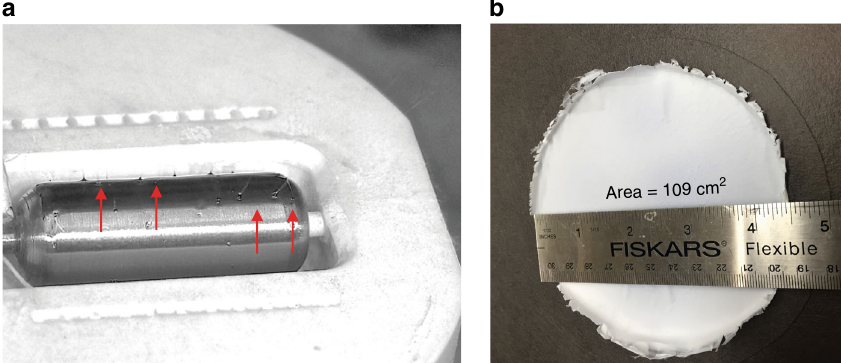
Fig. 6 Image of the rotating electrode and the collected sample on a carbon paper. Needle-free electrospinning can produce homogeneous and uniform fi lms over a large area. a Drum cylinder with multiple Taylor-cones (some are pointed at by red arrows) emerging on the surface of the rotating stainless- steel electrode at an applied potential of 50 kV. b Caesium dihydrogen phosphate-polyvinylpyrrolidone-polyaniline (CDP-PVP-PANI) composite material electrospun directly on a carbon paper from a clear solution. The fi lm was obtained within 10 minutes of electrospinning